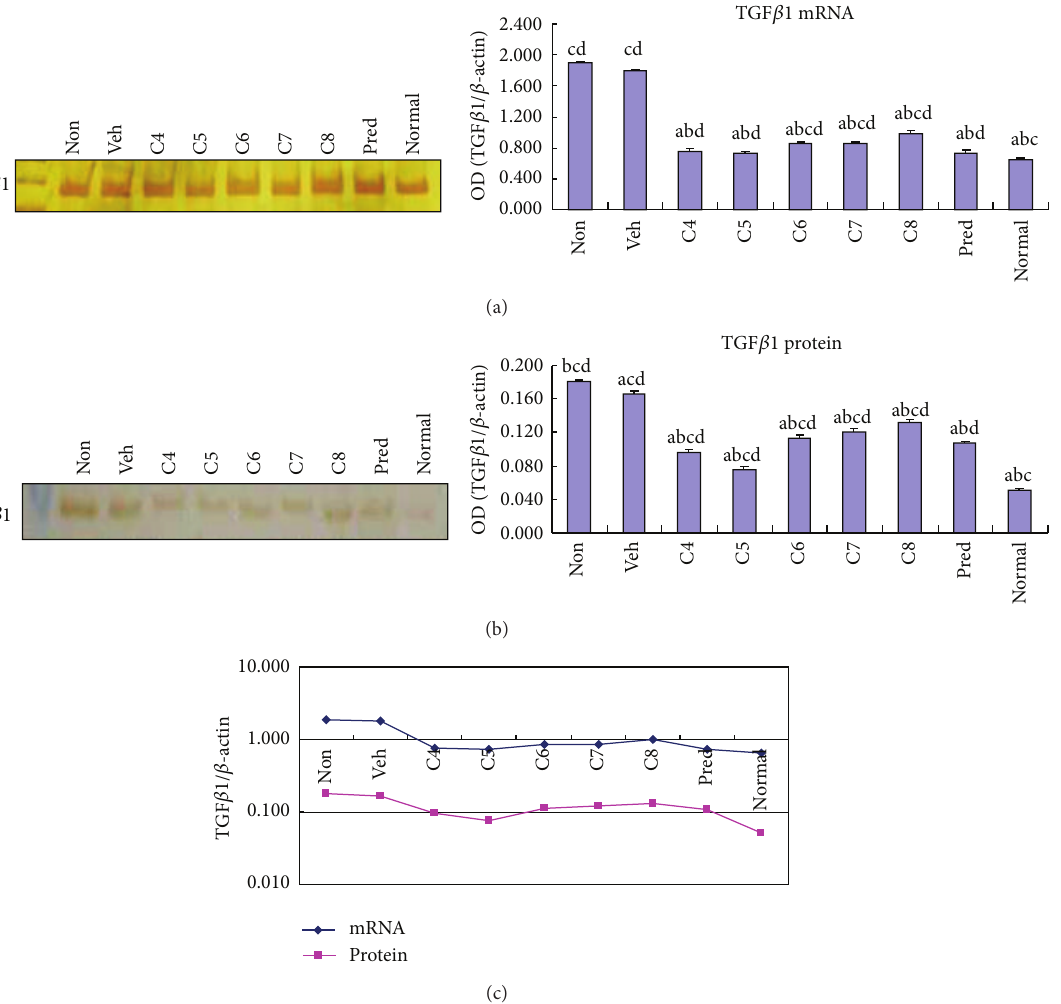
Figure 4: Treatment with Lactobacillus acidophilus reduced TGF 𝛽 1 expression in colitis. The mRNA (a) and protein (b) levels of TGF 𝛽 1 expression were examined by RT-PCR and Western blotting, respectively, in the colonic tissues of normal control mice group (normal) and DSS-induced mice groups, including L. acidophilus- treated C4–C8 groups, prednisone acetate treated positive control (Pred), and nontreated (Non) and vehicle (Veh) treated control groups. Representative electrophoresis images are shown on the left, and bar graphs presenting mean ± SD ( 𝑛 = 8 ) values are shown on the right. A plotted trendline chart shows TGF 𝛽 1 expression in each group at both mRNA and protein levels (c). a 𝑃 < 0.05 versus Non, b 𝑃 < 0.05 versus Veh, c 𝑃 < 0.05 versus Pred, and d 𝑃 < 0.05 versus